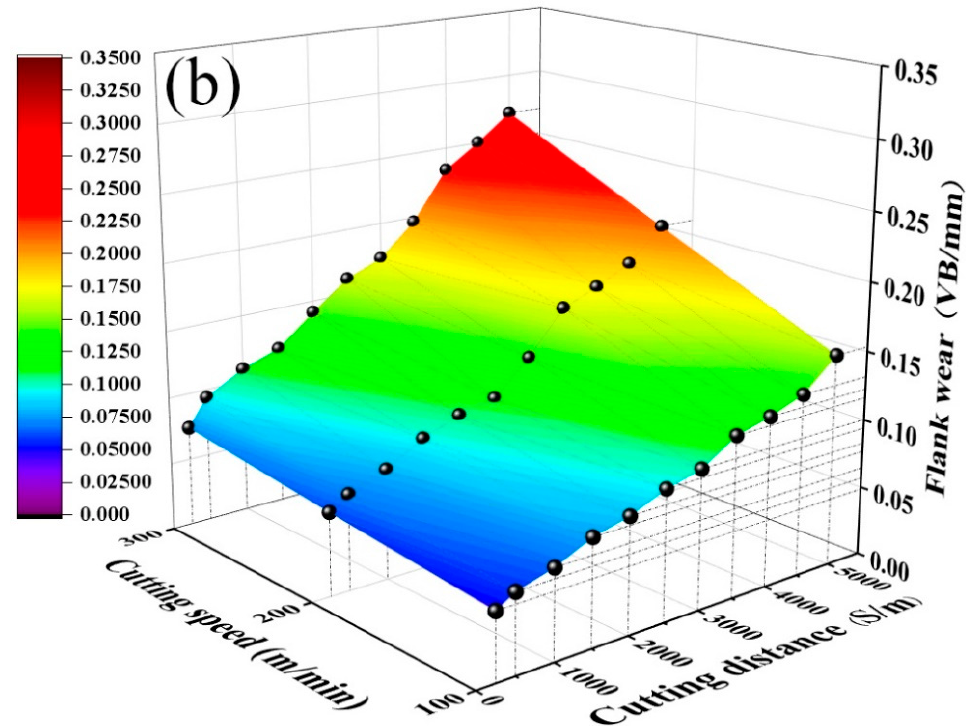
Figure 4. Curves of flank wear VB against cutting distance S under different cutting speeds: ( a ) ATS, ( b ) ATSC10.